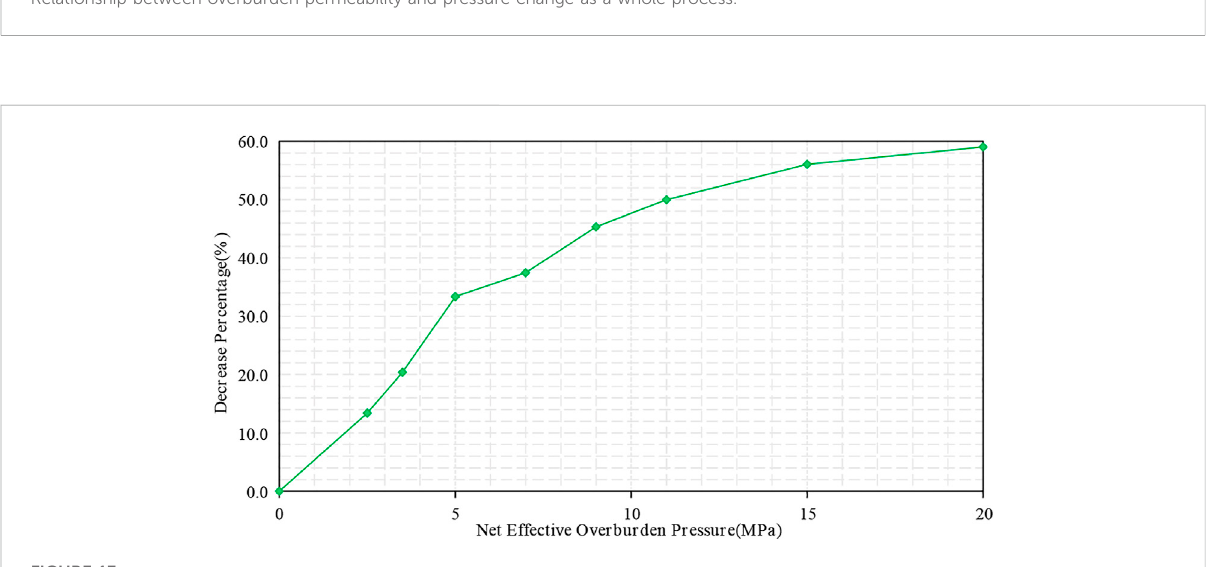
Decrease percentage of overburden permeability with increasing